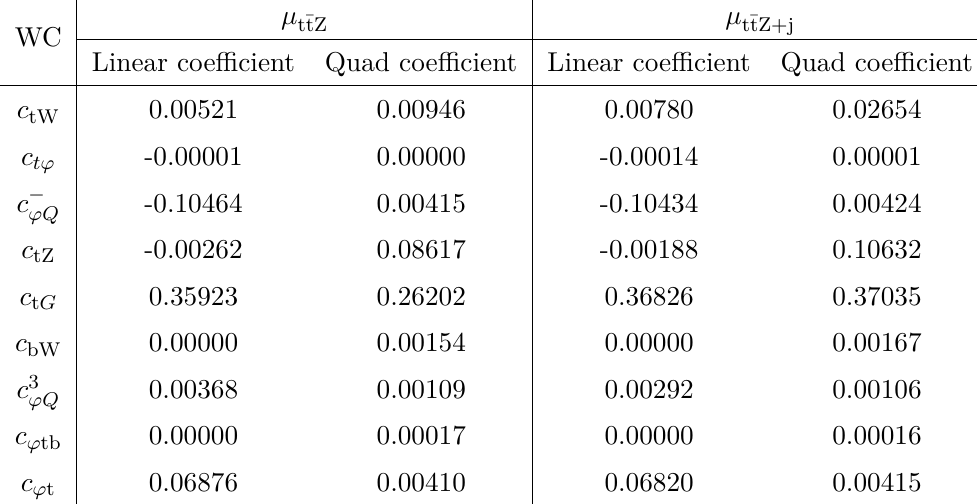
Table 7 . Summary of quadratic fit coefficients for the t¯tZ parameterization for µ t¯tZ and µ t¯tZ+j . As discussed in the text, the cross sections are normalized to the